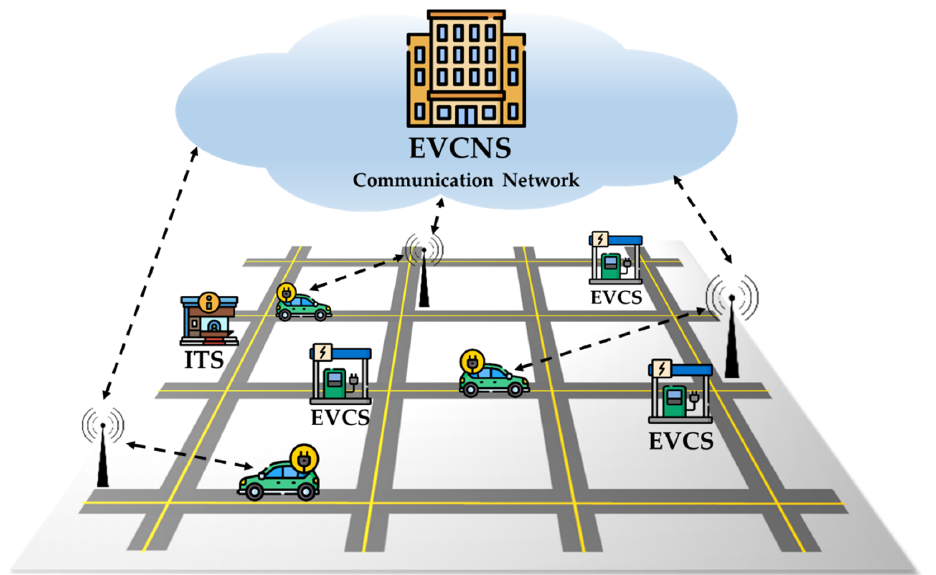
Figure 1. Overall architecture for the electric vehicle charging navigation system (EVCNS). EV: electric vehicle; EVCS: electric vehicle charging station; ITS: intelligent transport system.